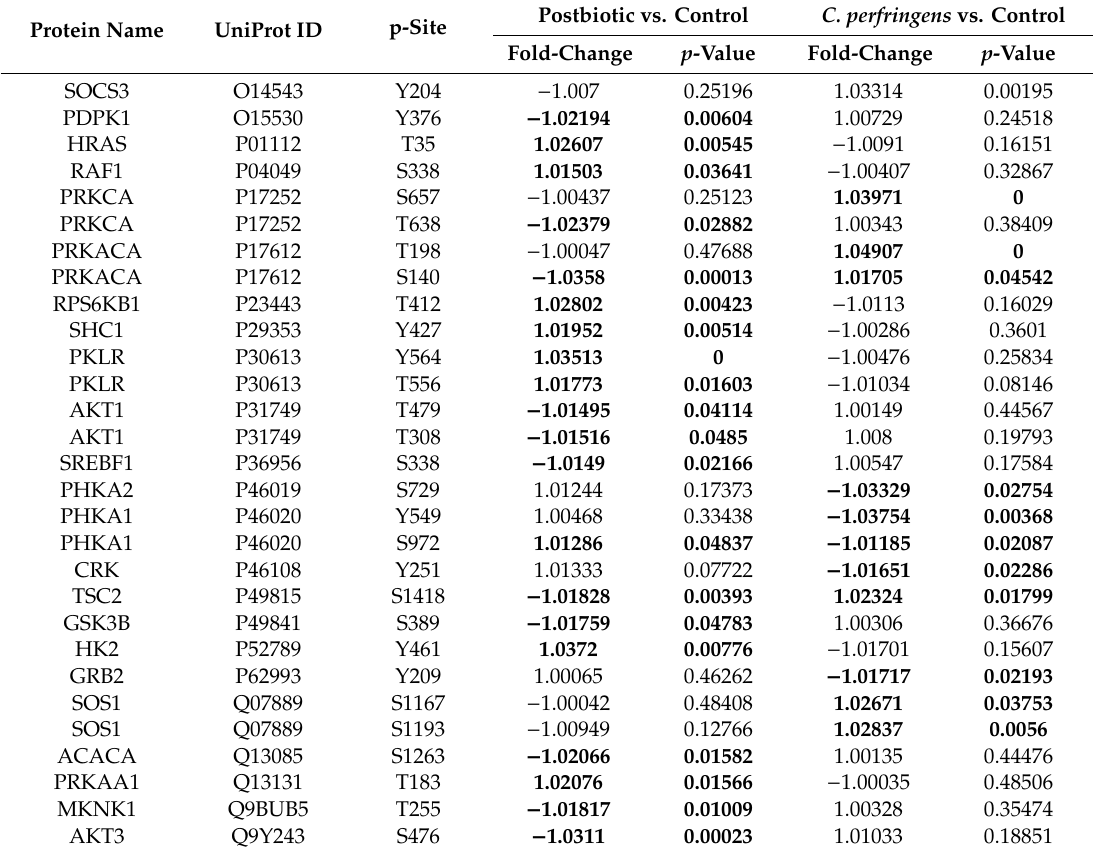
Table 11. Members of the insulin signaling pathway showing di ff erential phosphorylation in jejunal